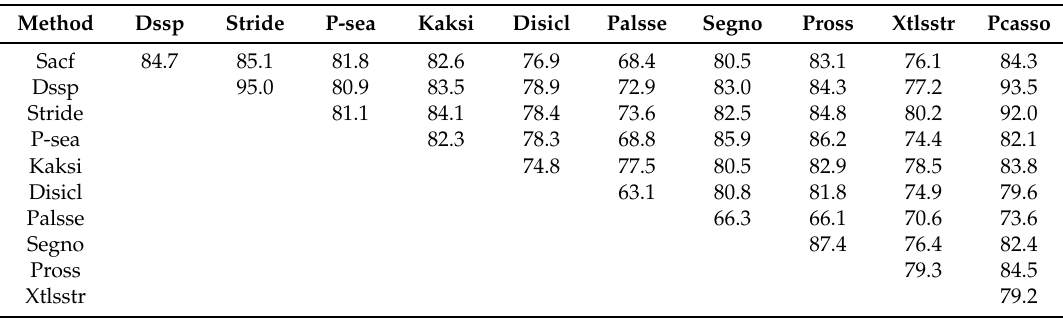
Table 1. The agreement (%) of eleven programs on set T . The agreement percentage was computed using Q3 score.